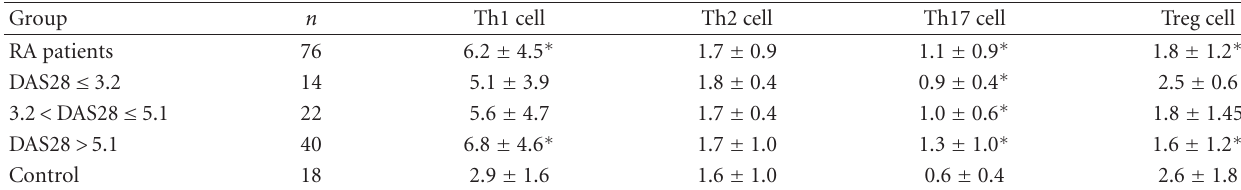
Table 1: The frequencies of Th1, Th2, Th17, and Treg cell in RA patients and control.